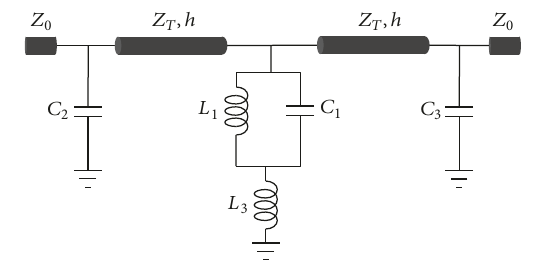
Figure 2: The equivalent circuit model of the proposed dual-band